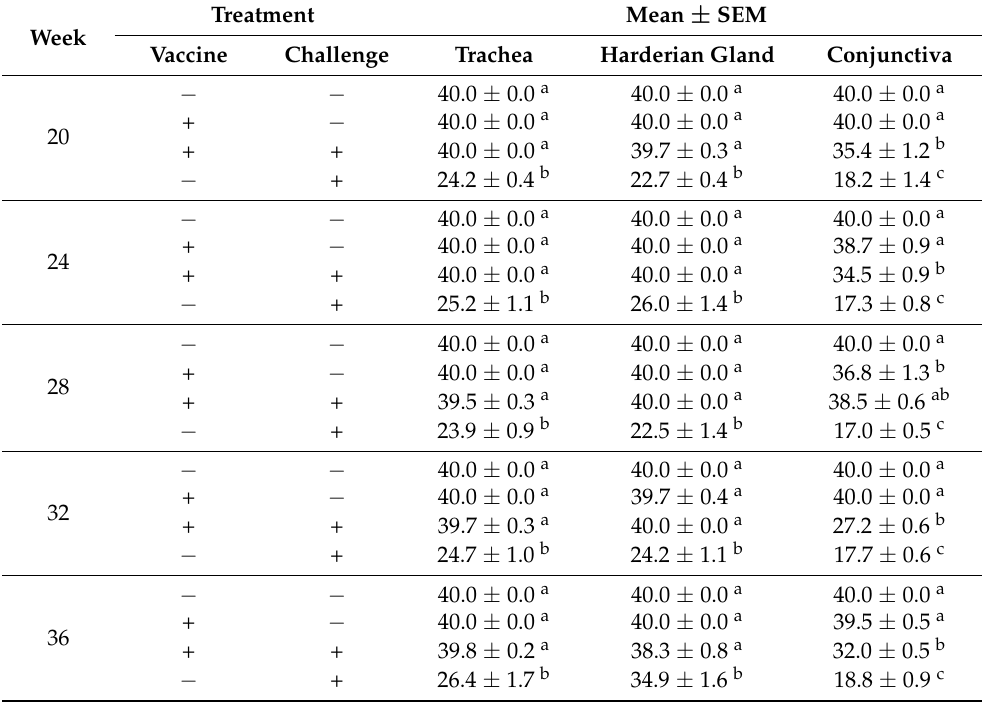
Table 5. Average qPCR CT values for ILTV DNA collected from trachea, Harderian gland, and conjunctiva 5 days post-challenge with pathogenic ILTV strain 63140. Letters (a–c) indicate significant differences among vaccine and challenge groups for each week ( p <